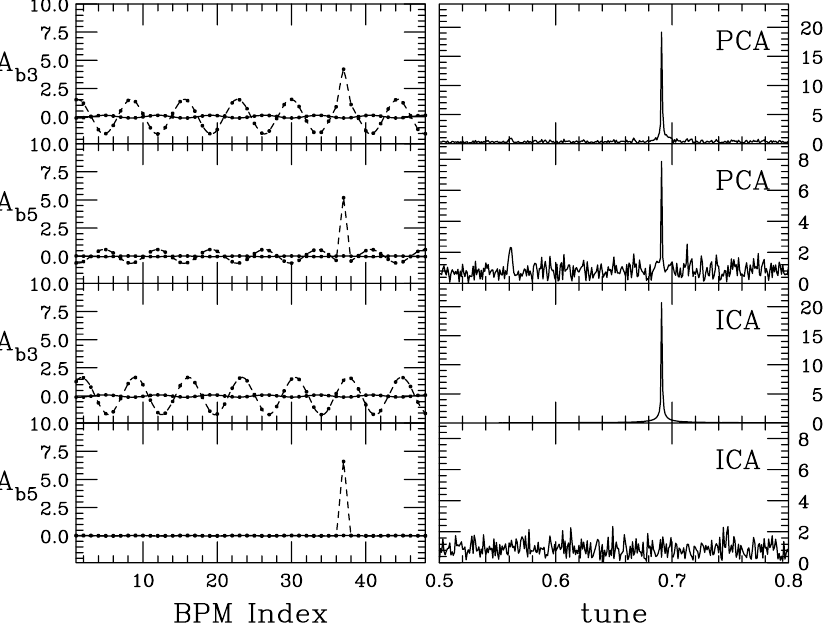
FIG. 3. The top and the second row are PCA modes of the LC model with a localized bad BPM with Gaussian white noise signal. (cid:3) 6 : 741 49 , (cid:30) (cid:3) 6 : 691 49 , C (cid:3) 0 : 05 , x (cid:3) 1 : 0 , y (cid:3) 0 : 0 A (cid:3) 0 : 9945 , A (cid:3) 0 : 0055 , B (cid:3) 0 : 0736 , B (cid:3) Model parameters: (cid:30) x z 0 0 1 2 1 2 (cid:15) 0 : 0736 . The signal added to BPM V37 is white Gaussian noise. The top row corresponds to mode 3 with SV (cid:3) 8 : 4 , and the second row is the mode 5 with SV (cid:3) 6 : 1 . The two PCA modes are mixed. The third and the fourth rows are ICA modes of the LC model with a localized bad-BPM Gaussian white noise. The localized ‘‘bad-BPM’’ mode is completely